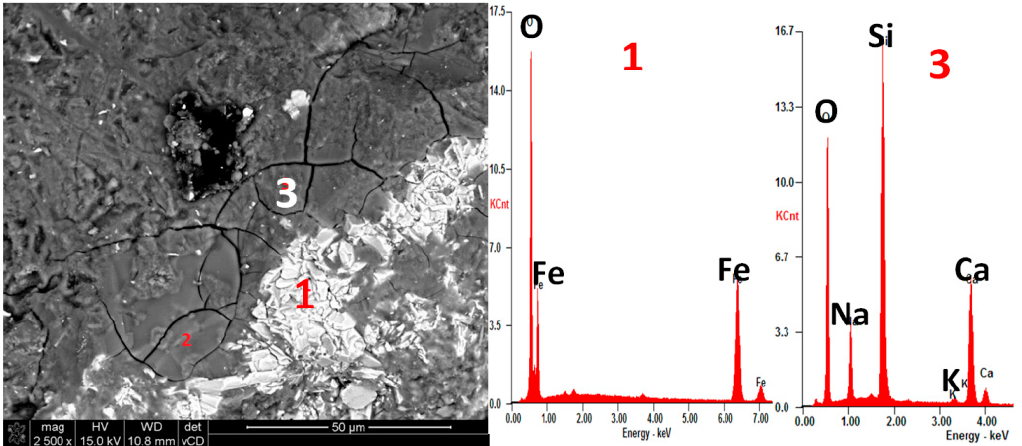
Figure 7. SEM microphotograph with EDX analysis showing the presence of (3) Si-Ca-Na gel in mortar bar with (1) hematite aggregate H1 after 28 days of exposure in 80 °C and 1 M NaOH.